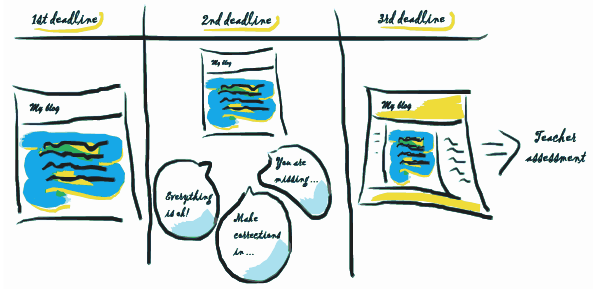
Figure 1. Illustration of the peer review